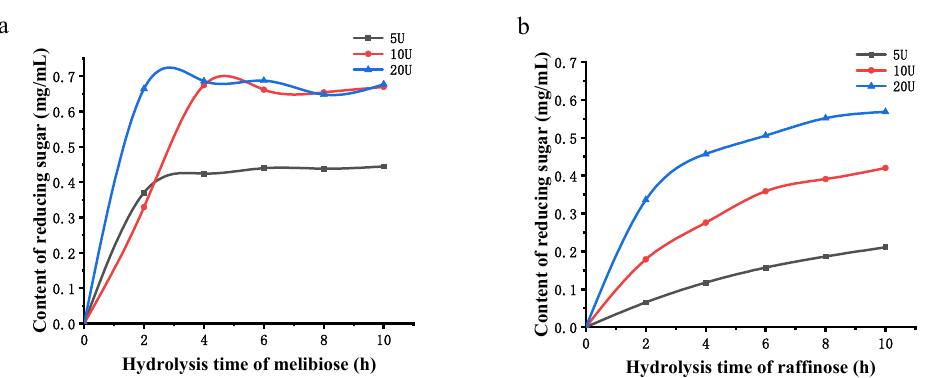
Figure 6. Reducing sugar content after treatment with α -galactosidase. ( a ) Reducing sugar content after the hydrolysis of melibiose; ( b ) Reducing sugar content after the hydrolysis of raffinose. The enzyme dosages are represented by different signals: gray square, 5 U/mL; red circle, 10 U/mL; blue triangle, 20 U/mL.